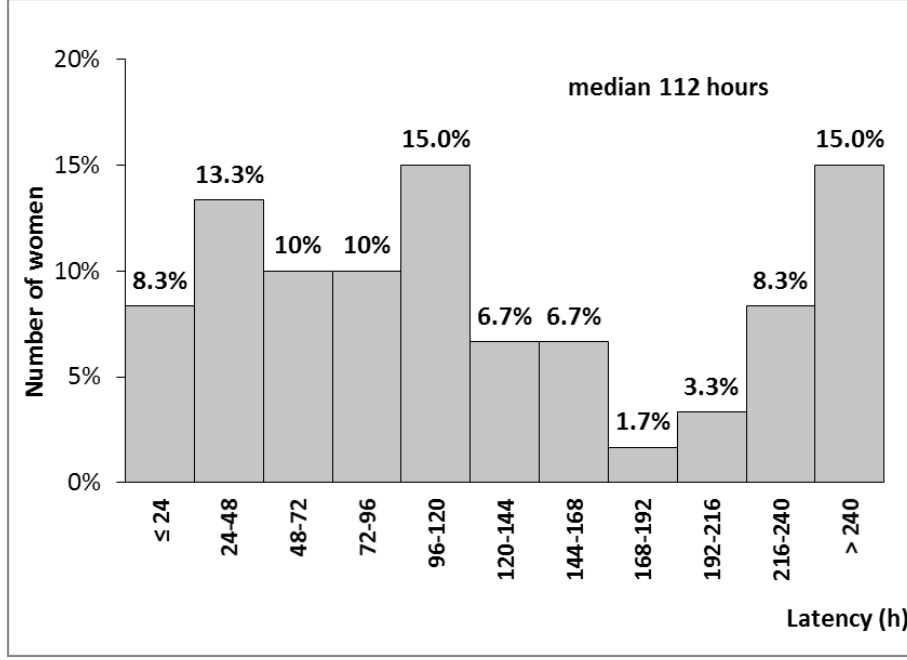
Fig. 2. Distribution of latency time from PPROM to